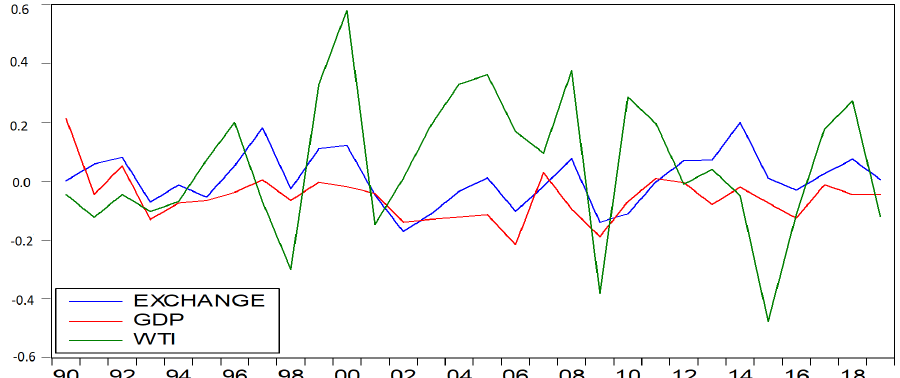
Figure 6. Graphical Expression for the Return Data of Exchange Rates of US dollar (US $)/Indian Rupee (INR), GDP per Capita and Dubai Crude Oil Price in US dollar (US $) during 1990 to 2020; Sources: Compiled bank.worldbank.org/home.aspx, and https://fred.stlouisfed.org/categoriesa, and computed using E. Views-10.